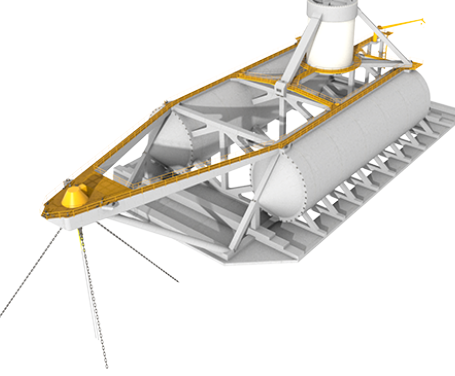
Figure 3. Saitec’s SATH substructure